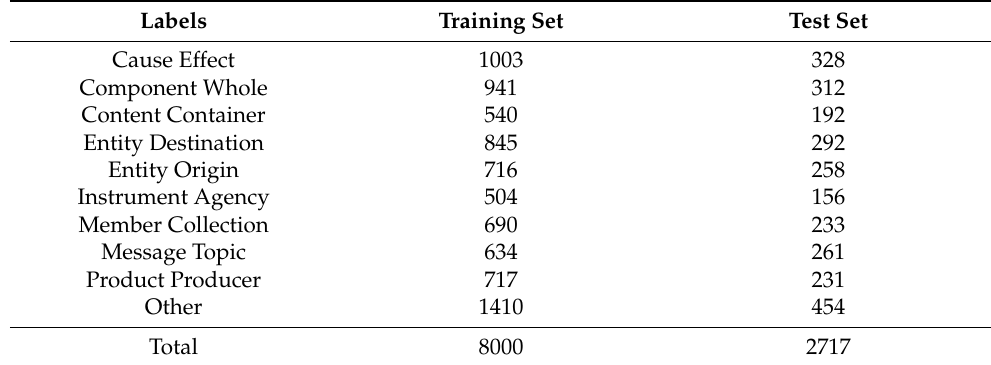
Table 3. The distribution of labels in the SemEval 2010 Task 8